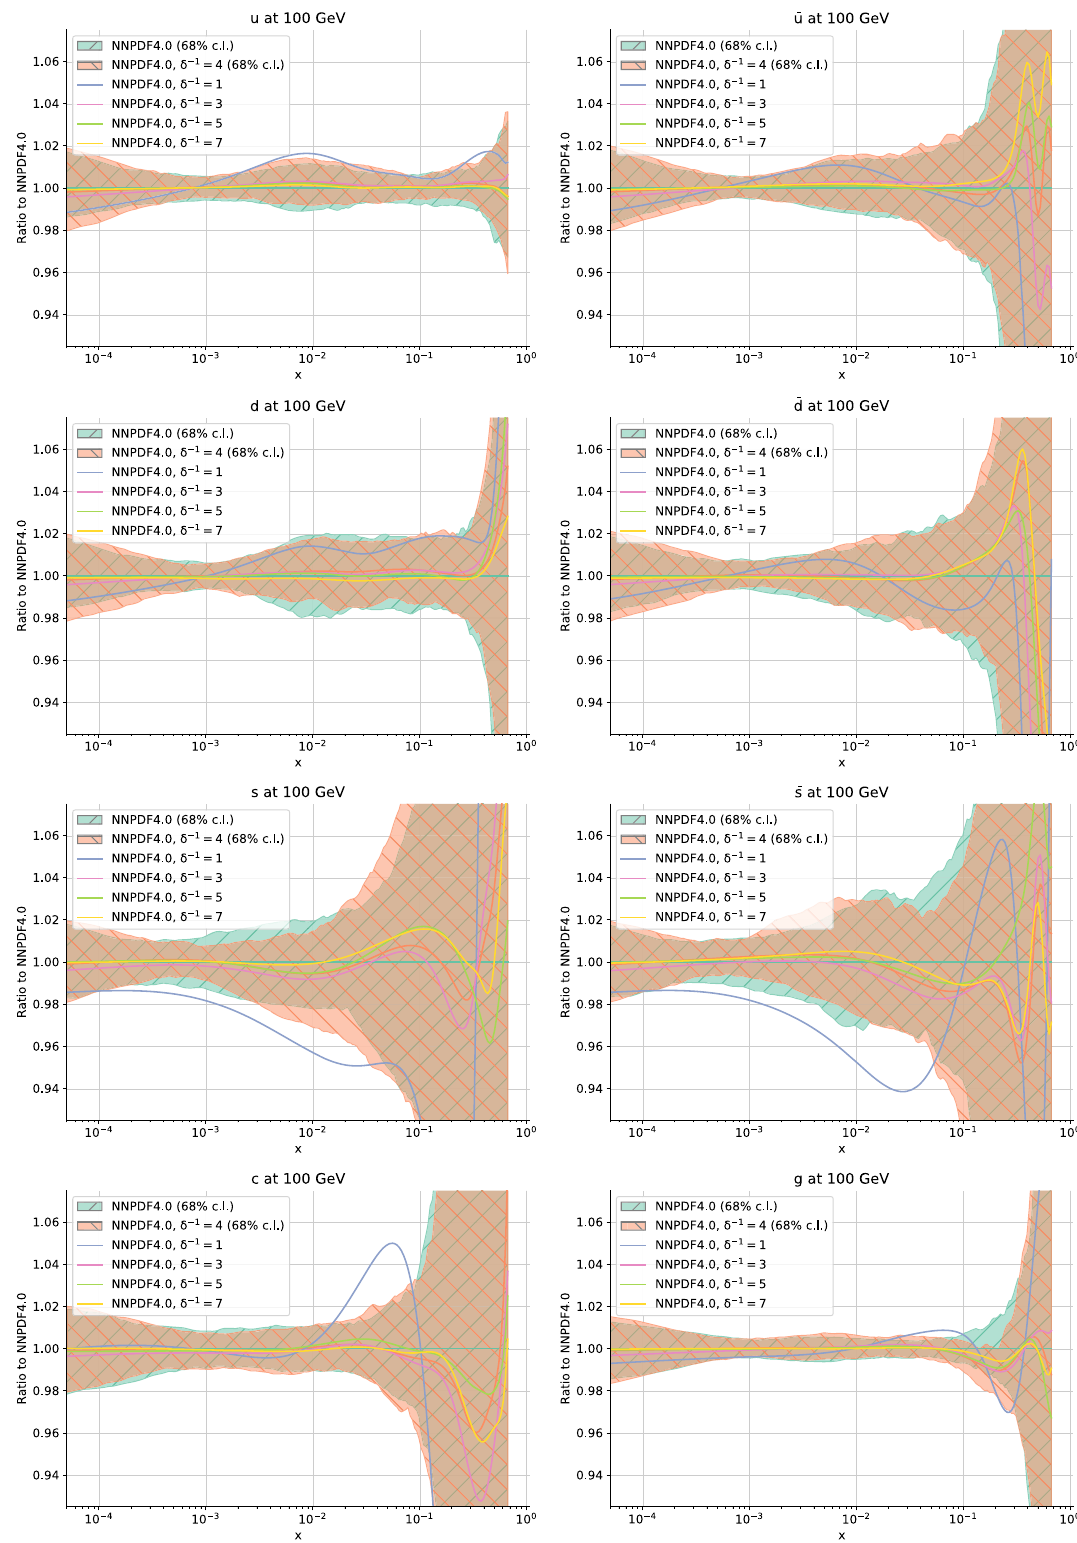
Fig. 4 The PDFs obtained by fitting the NNPDF4.0 data set after reg- ularisation with different values of the parameter δ − 1 = 1 , 3 , 4 , 5 , 7. From top to bottom, left to right, we show the up, anti-up, down, anti-down, strange, anti-strange, charm and gluon PDFs at a scale